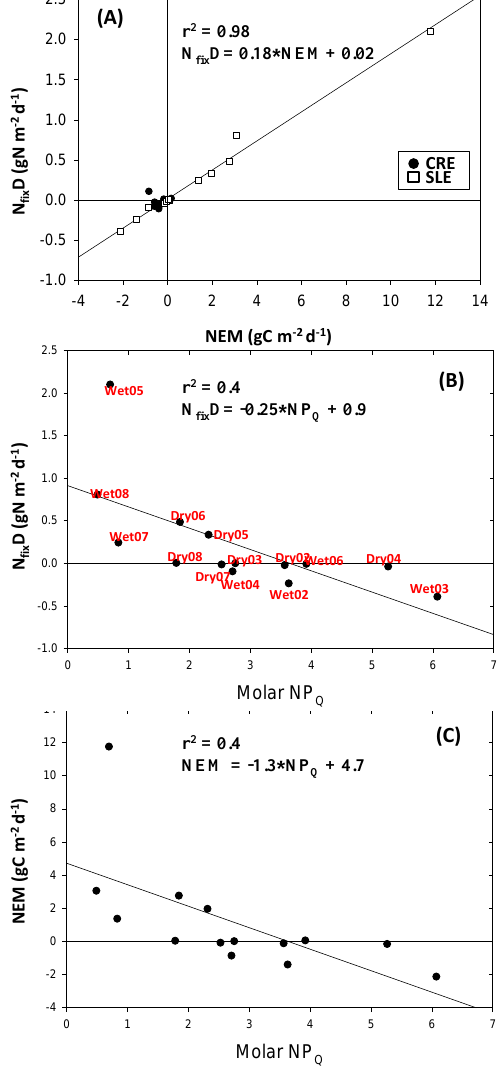
Fig. 10. Scatter plots from seasonal DIN and DIP budgets for CRE and SLE from 2002 to 2008. (A) Both the CRE (filled circles) and the SLE (open squares) presented with net ecosystem metabolism (NEM) vs. the difference between N 2 fixation and denitrification (N fix D). Regression lines, r 2 values, and equations provided for the SLE points only. (B) Scatter plots of seasonal values from the SLE from 2002 to 2008. Relationship between the DIN:DIP ratio of loading (independent) and N fix D (dependent). (C) Relationship between the DIN:DIP ratio of loading as the independent variable and NEM as the dependent